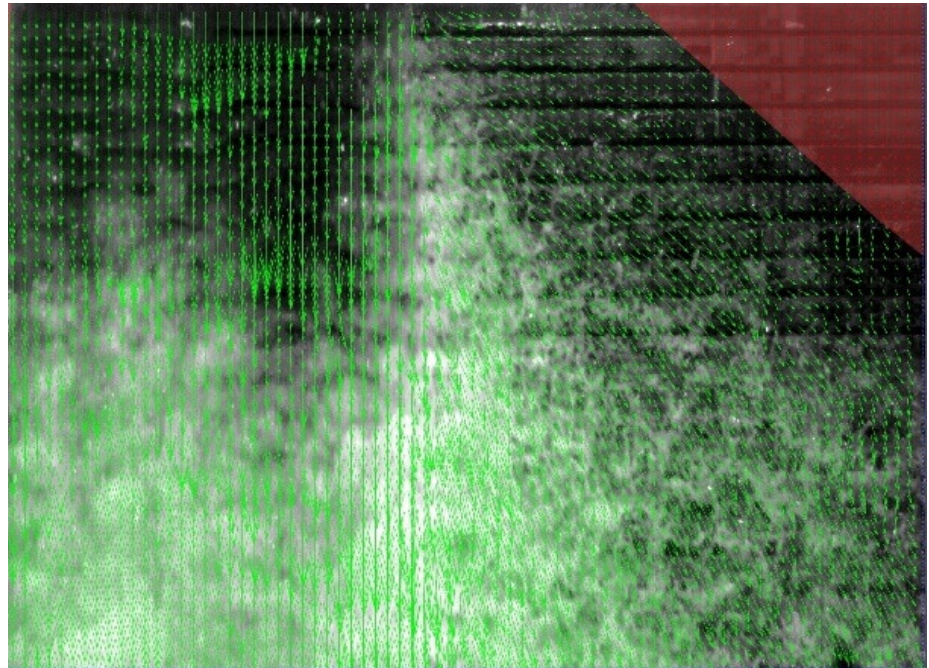
/ℎ = 2.38 . Figure 13. Post-processed frontal velocity field obtained in frame 691 for d